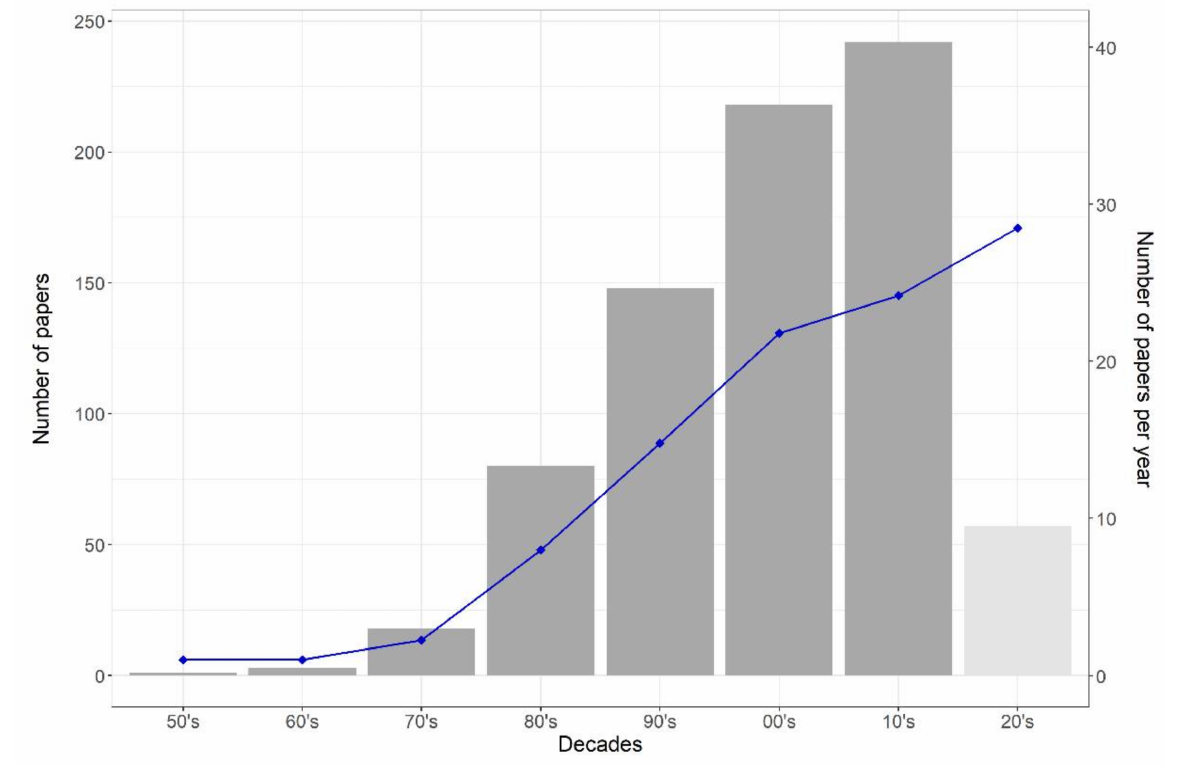
Figure 2. Number of papers per decade. The bars indicate the total number of papers retrieved in each decade, from the 1950’s to the 2020’s. The blue points indicate the average number of papers per year retrieved in each decade. The papers corresponding to the 2020’s consider only the years 2020 and 2021 (light grey).